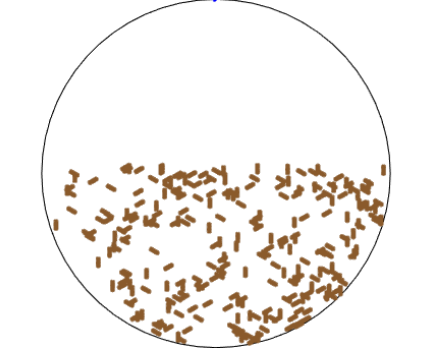
Figure 4. Initial position of scenario 1.